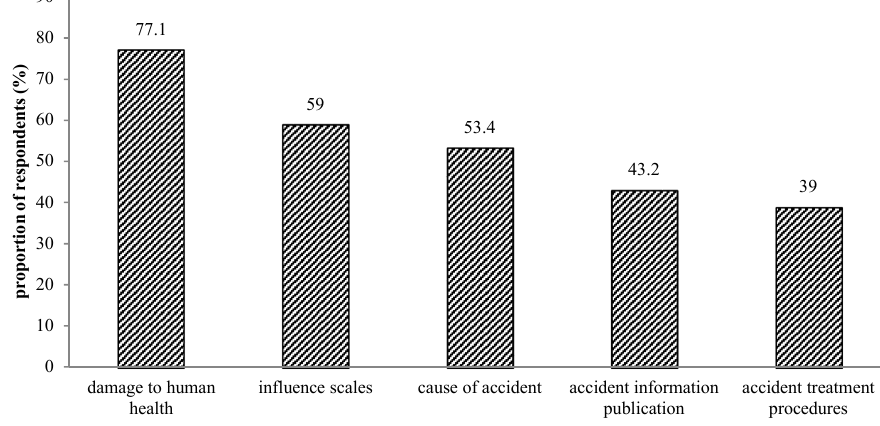
Figure 3. Public knowledge about water pollution accidents. Note: the same respondent ticked more than one alternative.